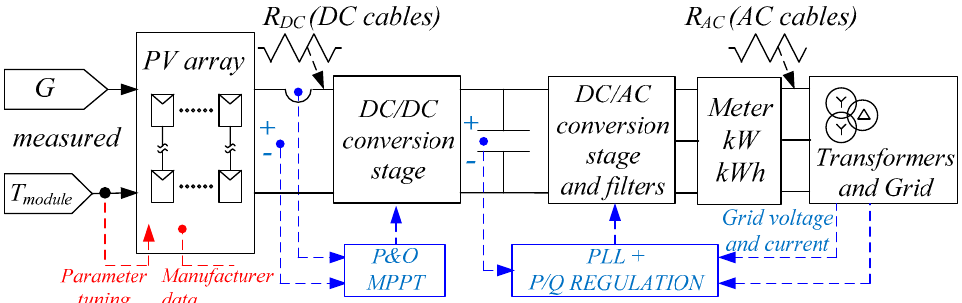
Figure 4. PV plant basic scheme. G is the measured irradiance, T module is the module temperature, P&O is the Perturb and Observe algorithm.